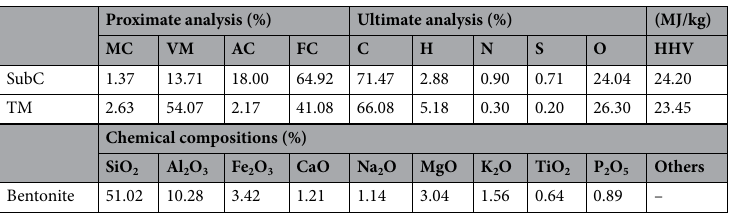
Table 1. Properties of raw materials for production of briquette. MC moisture content, VM volatile matter, AC ash content, FC fixed carbon, C carbon, H hydrogen, N nitrogen, S sulphur, O oxygen, HHV calorific value, TM torrefied biomass and SubC subbituminous